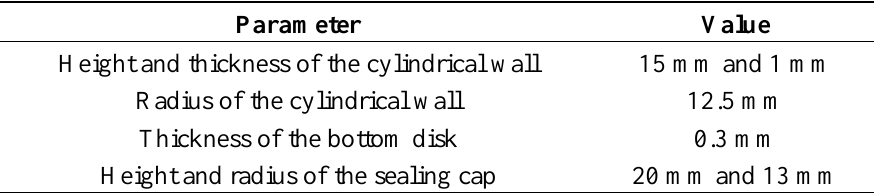
Table 1. Geometric parameters of the gyroscope.